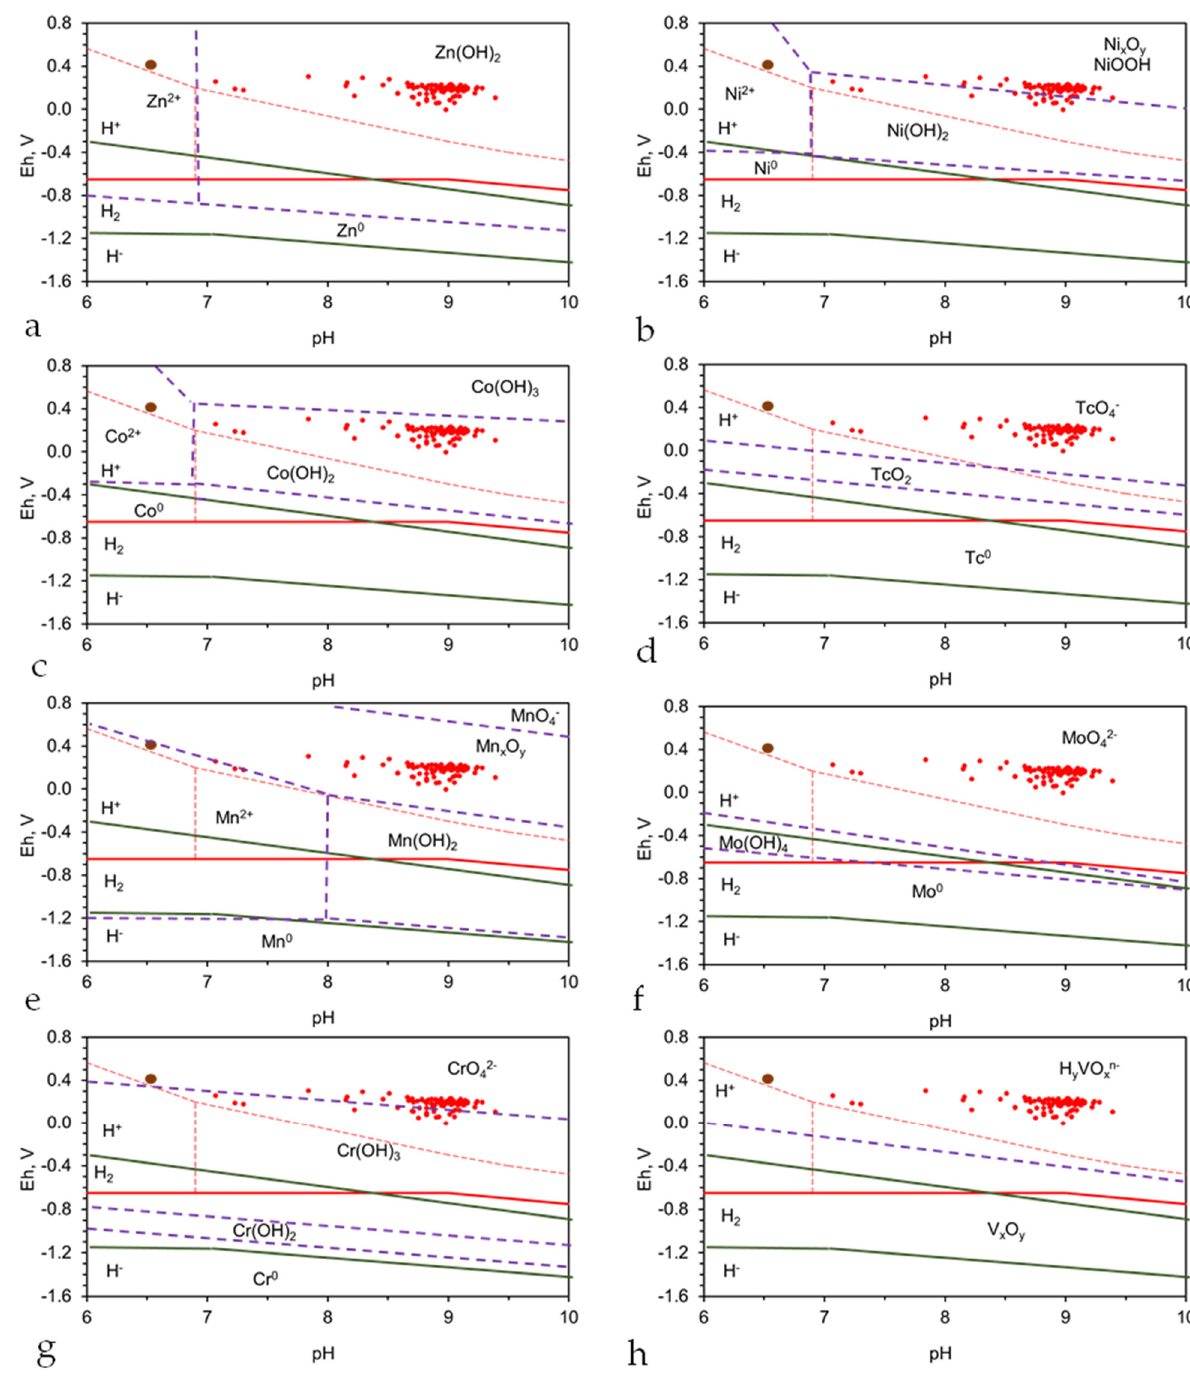
Figure A12. Eh and pH of product water (red dots) relative to redox fence locations. ( a ), Cadmium; ( b ), Nickel; ( c ), Cobalt; ( d ), Technetium; ( e ), Manganese; ( f ), Molybdenum; ( g ), Chromium; ( h ), Vanadium. Dashed Purple Line = contaminant redox fence boundary; Eh:pH product water data: Figure A10; Brown data point = feed water.